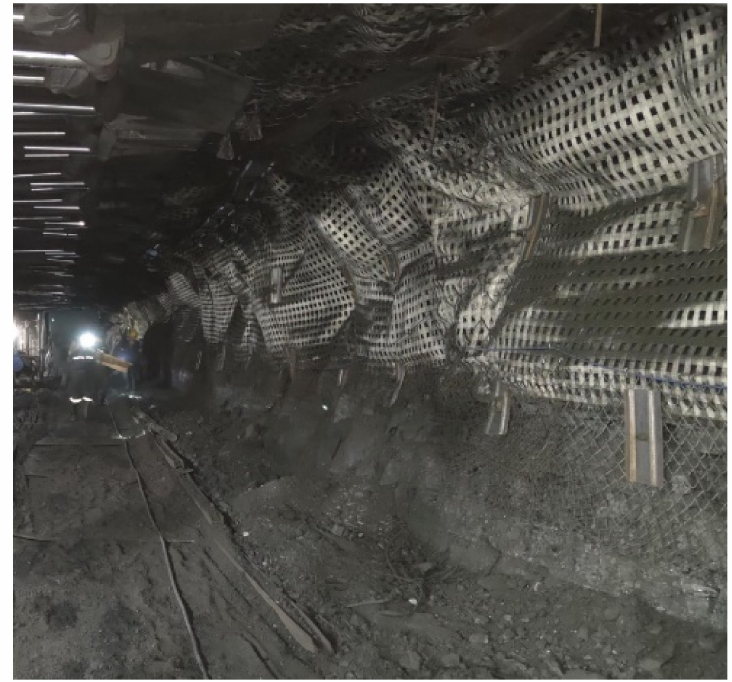
Figure 26. Effect picture of on-site